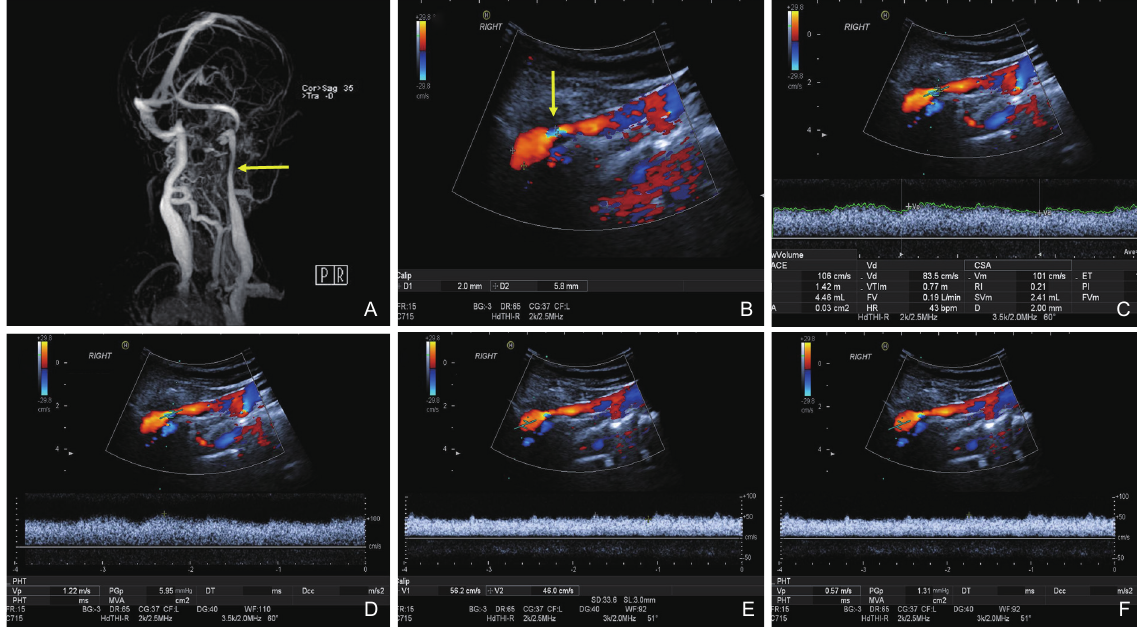
Figure 1 MRV and ultrasound images of a 56-year female with right IJV stenosis. (A) MRV showed there was stenosis on the right IJV at the J3 distal segment (yellow arrow). (B) Color Doppler flow imaging showed there was stenosis on the right IJV at the J3 distal segment (yellow arrow). (C) and (D) The wave-form at the stenosis site with a diameter 2.0mm, Vmax (Vp) 106cm/s and PGmax (PGp) 5.95 mmHg. (E) and (F) The wave-form at the segment distal to the stenosis with a Vmax (V1) 56.2cm/s and PGmax (PGp) 1.31mmHg.